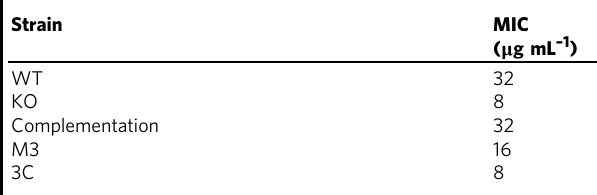
Table 1 MIC of LL-37 against wild-type S . pneumoniae